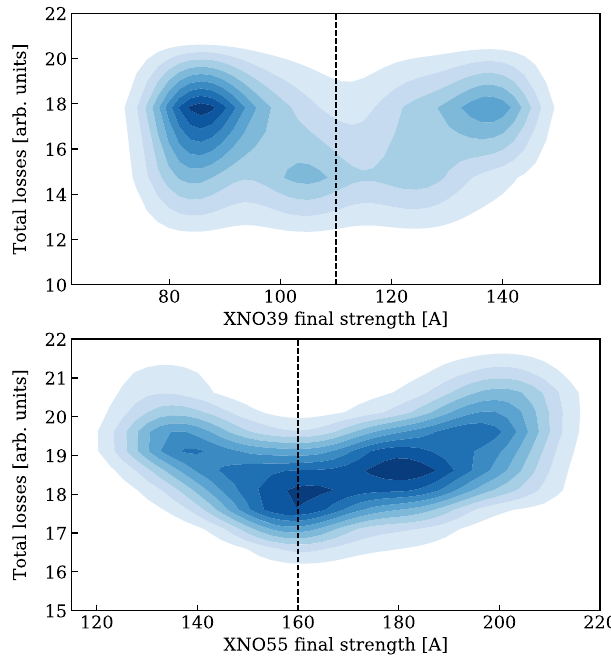
FIG. 5. Distribution of extraction losses as a function of the final strength of the sextupoles XNO39 (upper) and XNO55 (lower) during the separation of the islands and the change of their phase. A clear dependence is visible for XNO55, while almost no dependence is observed for XNO39. The vertical dashed lines represent the values of the operational currents.